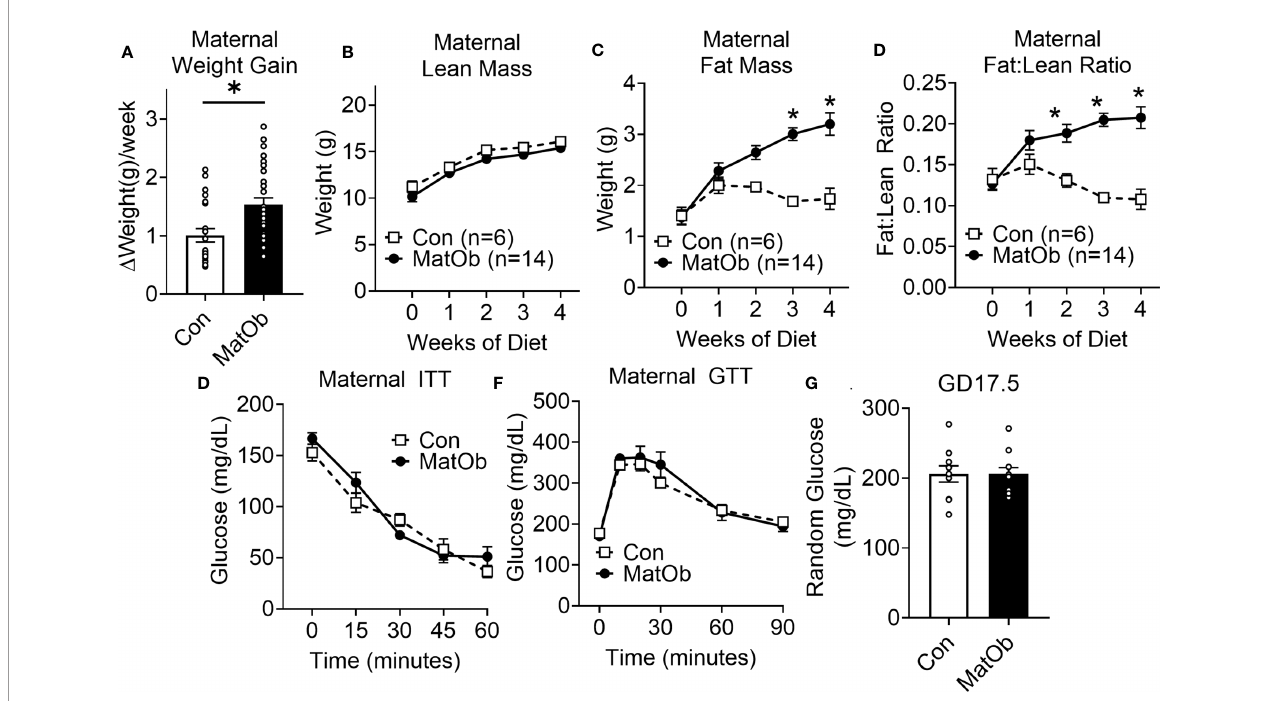
FIGURE 1 | Female dams had increased body adiposity and unchanged glucose and insulin tolerance prior to mating (A) Average maternal weight gain per week during western style diet (n= 22-30/group). (B – D) EchoMRI was performed on week 0, 1, 2, 3, and 4 on western diet to measure maternal lean weight, fat weight, and fat:lean ratio (n=6-14/group). Prior to mating after completing 4 weeks of diet, female dams had unchanged (E) ITT (n=6-9/group) and (F) GTT (n=8/group) (G) Maternal glucose level at E17.5 (n=13-14/group) (*p <